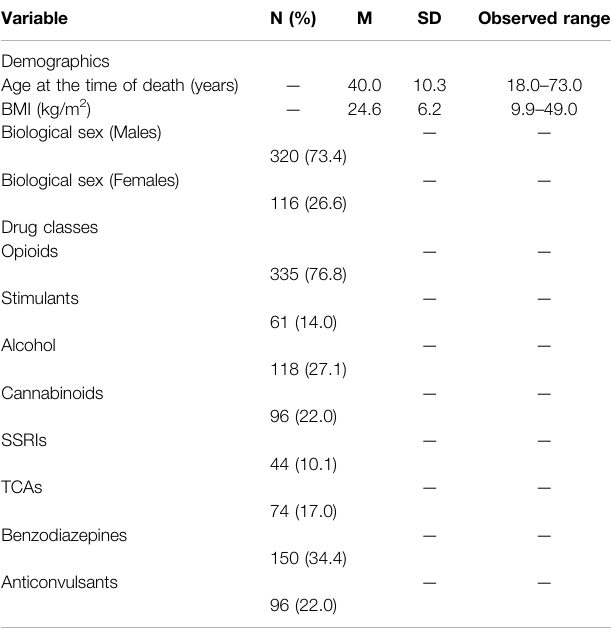
TABLE 1 | Demographic characteristics at the time of death and drug classes identi fi ed in 436 PMRs.